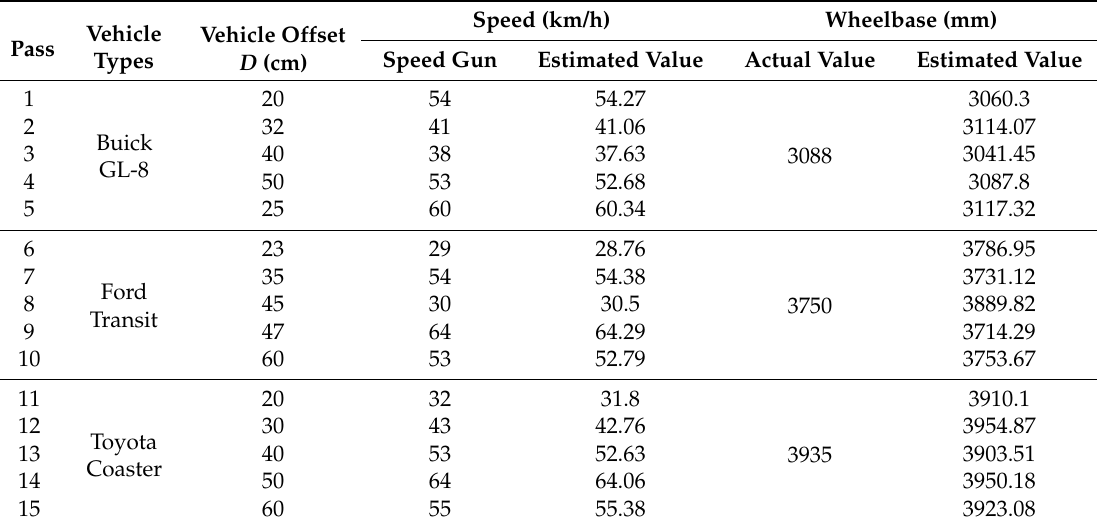
Table 2. Vehicle speed and wheelbase estimates.